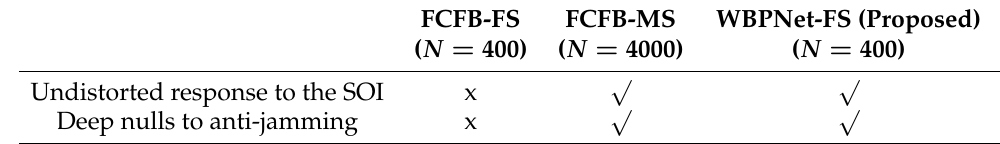
Table 1. The performances of existing and proposed algorithms on